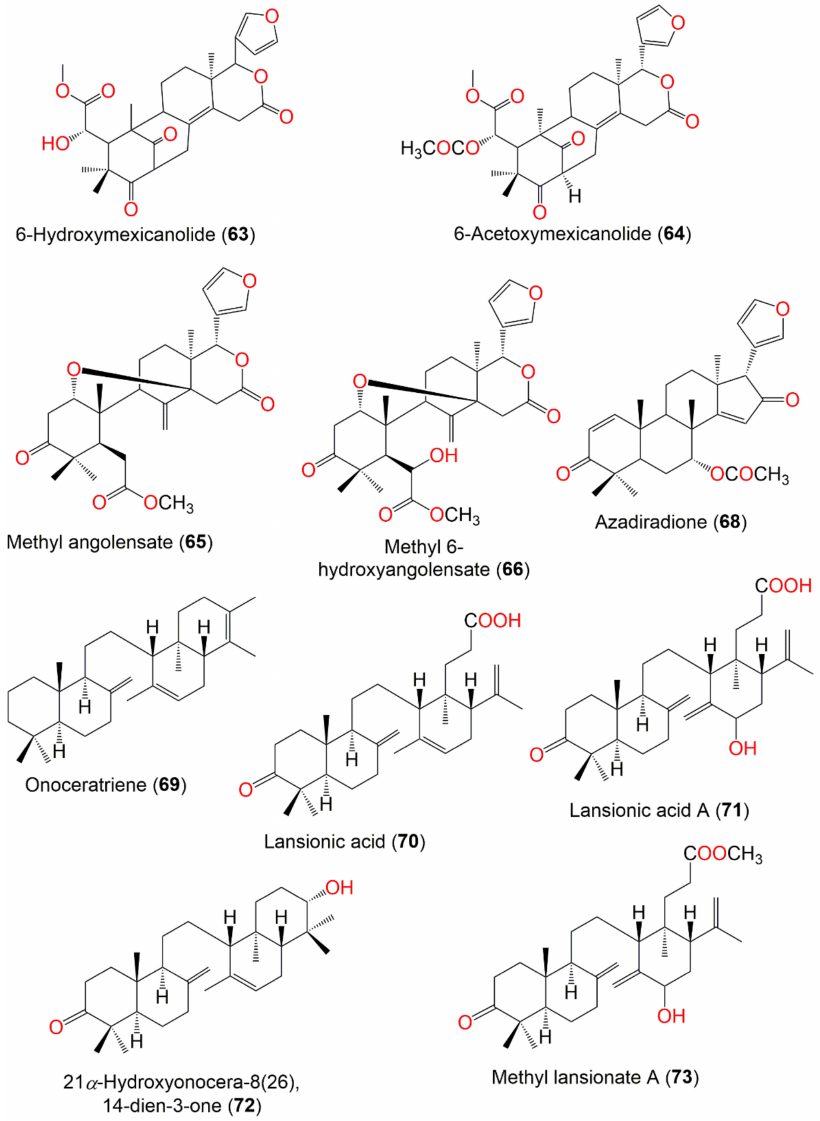
Figure 6. Structures of compounds 63 – 73 from Lansium domesticum